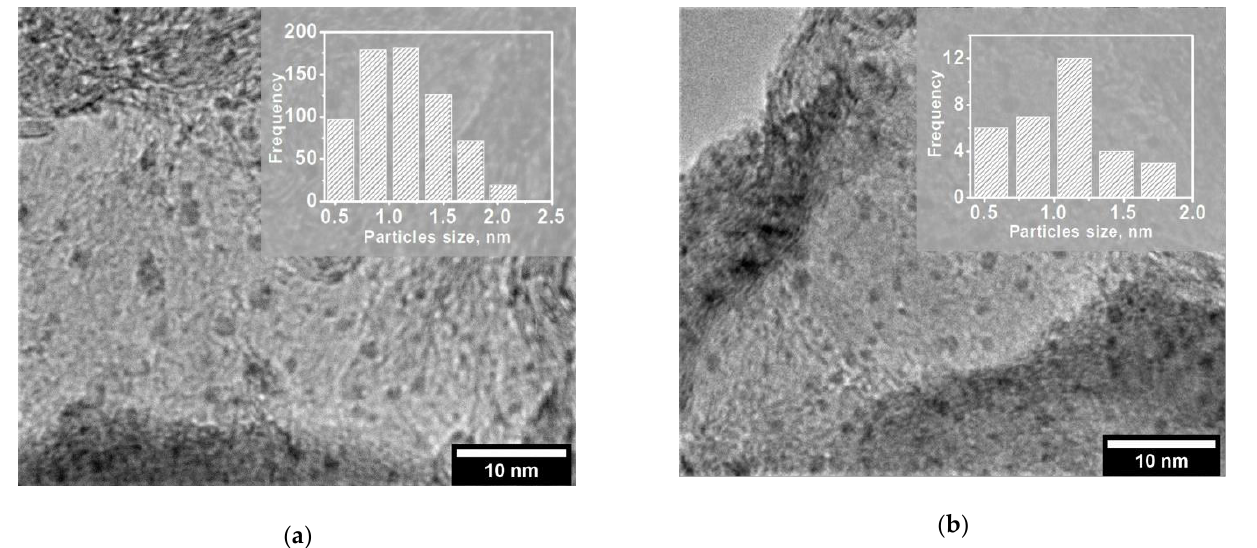
Figure 1. Transmission electron microscopy images of ( a ) the 3%Ru/Sib-4 and ( b ) 1%Ru/Sib-4-ox-450 catalysts.